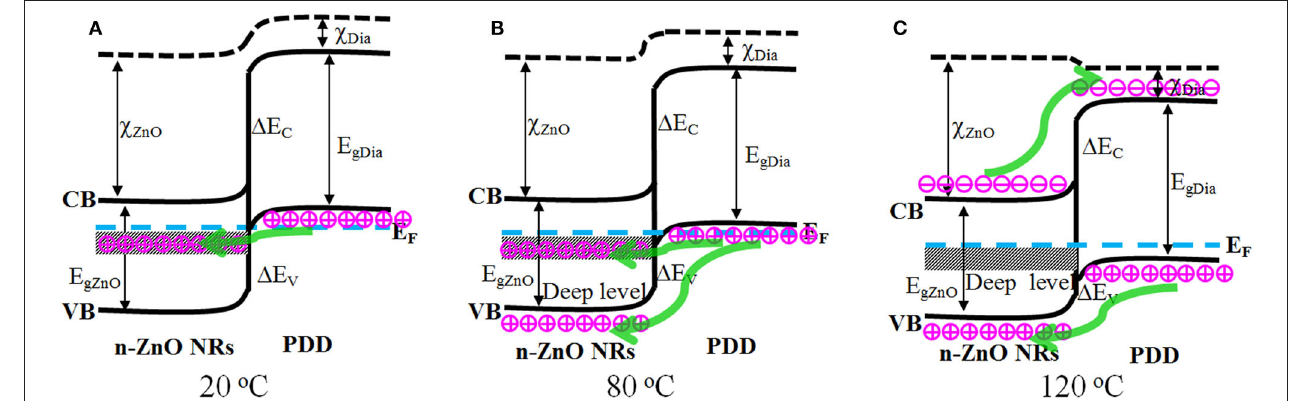
FIGURE 4 | Energy band diagram of n-ZnO NRs/p-degenerated diamond heterojunction at (A) 20, (B) 80, and (C) 120 ◦ C.